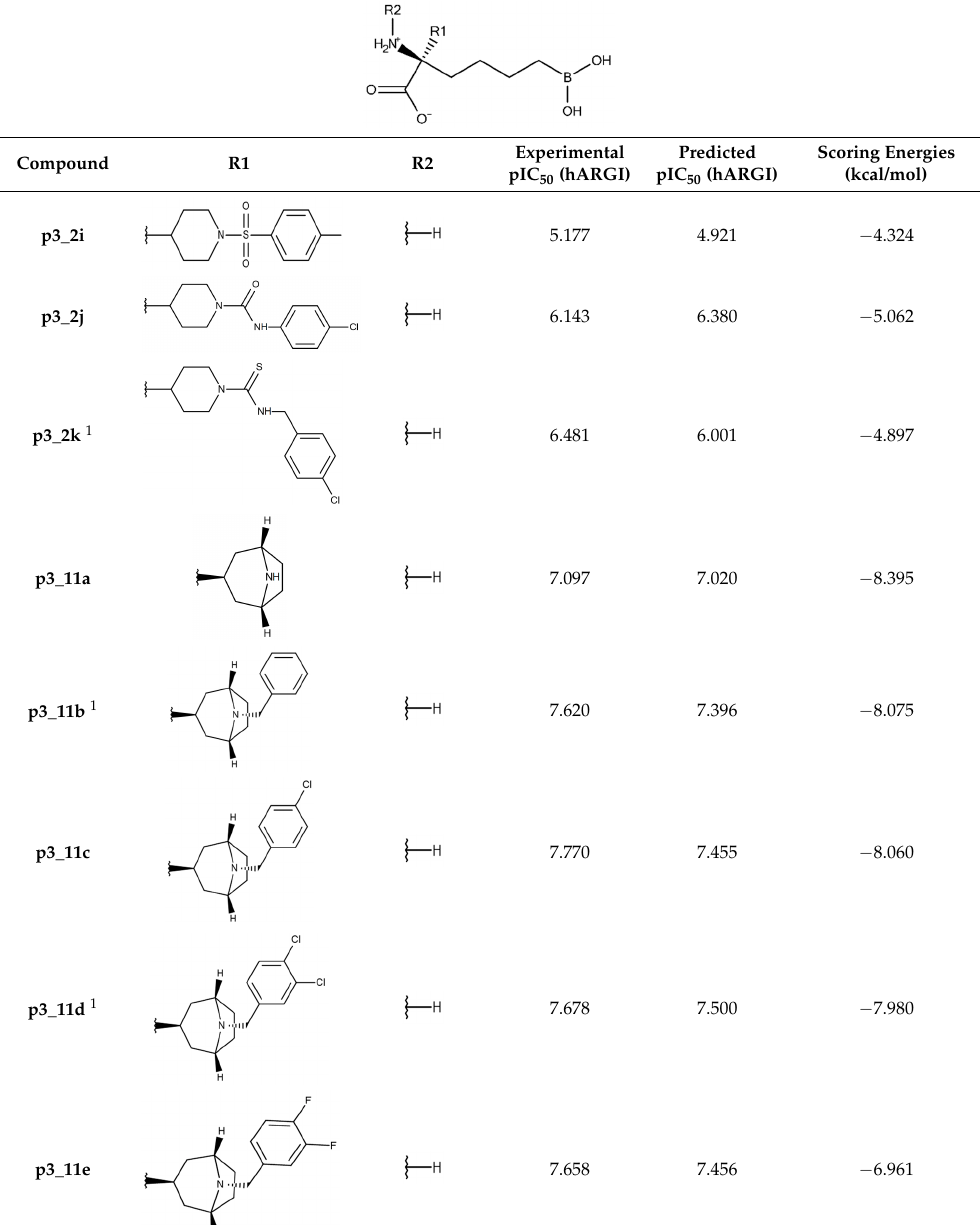
Table 1. Structures of ABH analogs as hARGI inhibitors. Experimental and predicted pIC 50 values using Model SE and docking Glide scoring energy values .